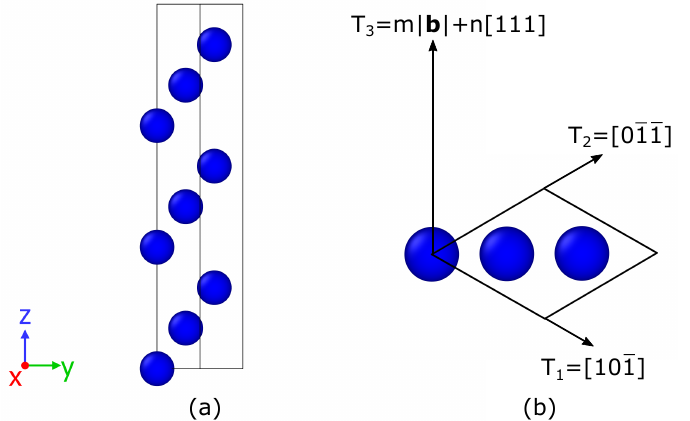
Figure A1. ( a ) Front view of 9 atom supercells used for the SFE calculation. ( b ) Top view of 9 atom hexagonal supercell stacked along (111) fcc planes. Corresponding vectors T 1 , T 2 , and T 3 are also shown.